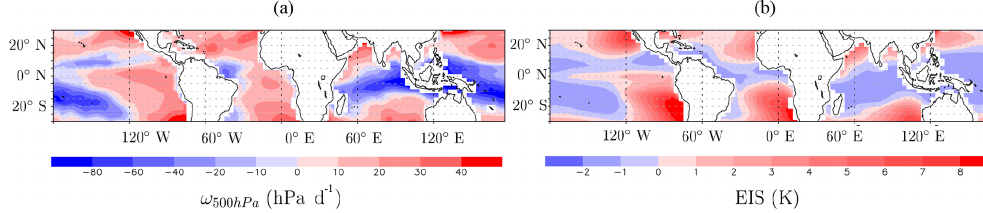
Figure 6. Maps of winter-mean ω 500 (a) and EIS (b) simulated by LMDZ. Table 1. Equations to calculate the relative contributions of r orig , α eff , SST, h 0 , φ , and η to δD 0 and the physical meaning of these contribu-